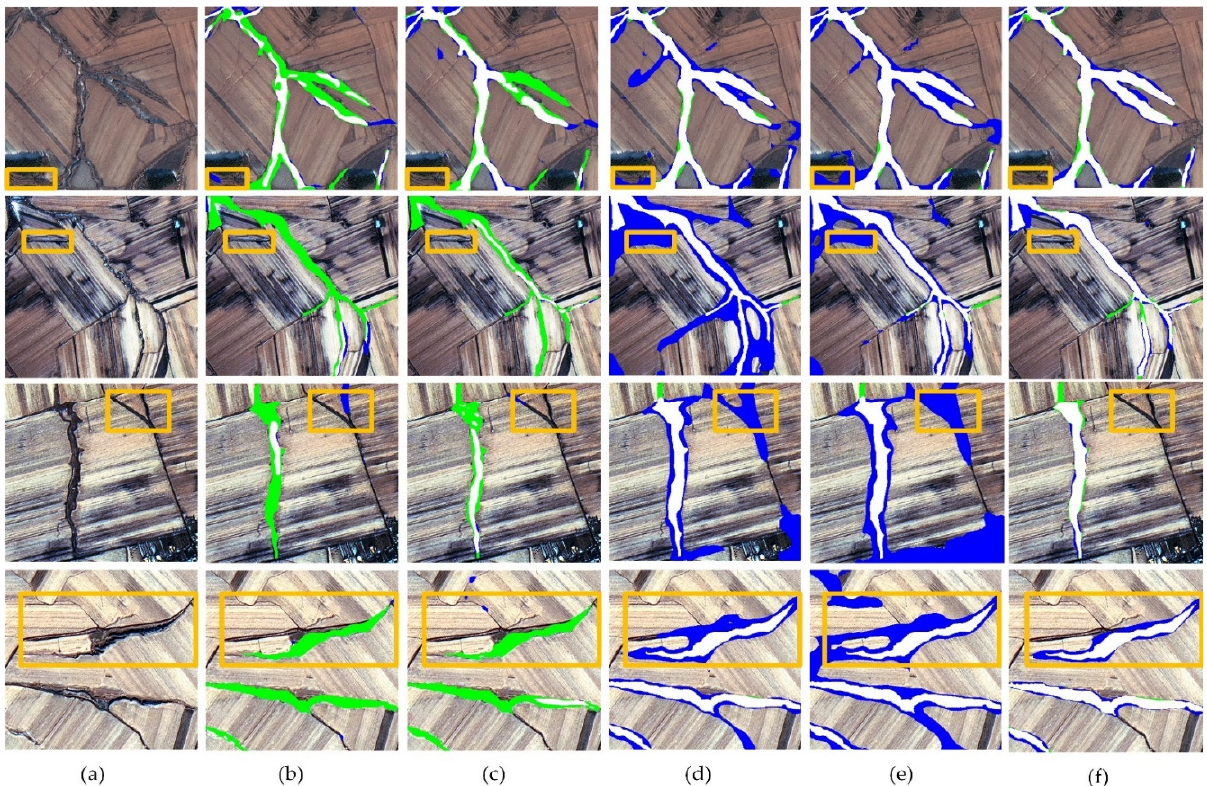
Figure 7. The latest monitoring data of Experiment 1 and corresponding labels. Among them, the colored rectangles are the representative lands, and the white as well as black pixels in the labels separately represent gully erosion and non-gully erosion.